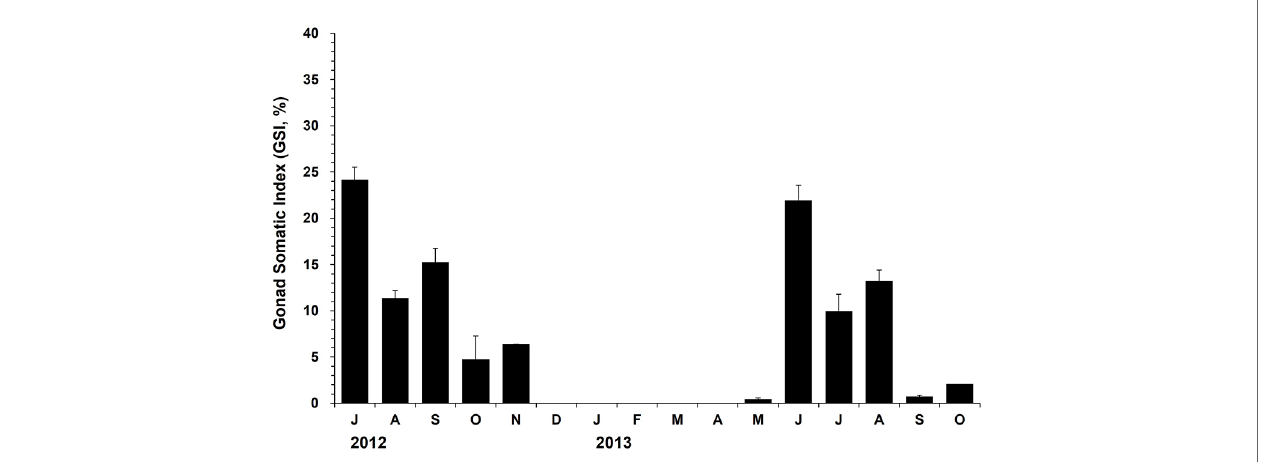
FIGURE 6 | The monthly mean gonad somatic index (GSI) of the female oysters determined using ELISA. The vertical bars on each monthly mean represent the standard error.